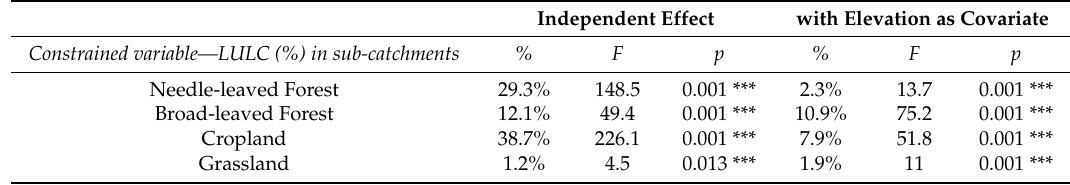
Table 3. Independent effect of main LULC (with distinction between forest types) on water quality and effect when removing shared effect with elevation, F and p values of the models.